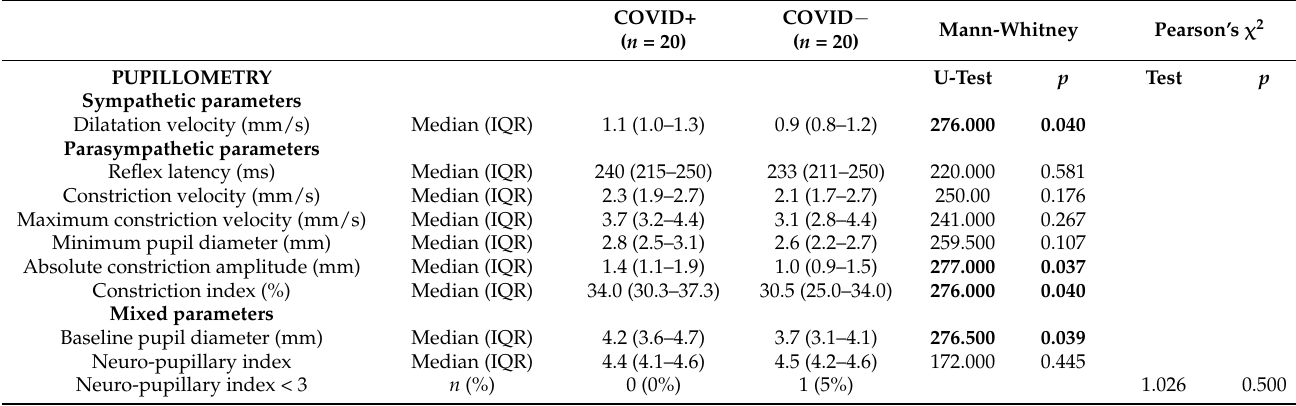
Table 3. Results of automated pupillometry analysis. Categorical variables are expressed as number ( n ) and percentage (%), and numerical variable as median and interquartile range (IQR). For categorical variables, we adopted the Pearson’s χ 2 test. Numerical variables were analyzed by means of Mann-Whitney U-test. Significance was set at p < 0.05. We can see highlighted the results that reached statistical